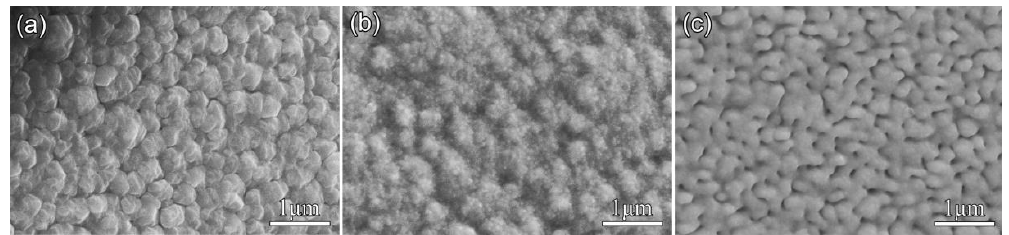
Figure 4. SEM micrographs of the fabricated Cu-Ti films on C17200 Cu alloy: ( a ) F1, ( b ) F2, and ( c ) F3.